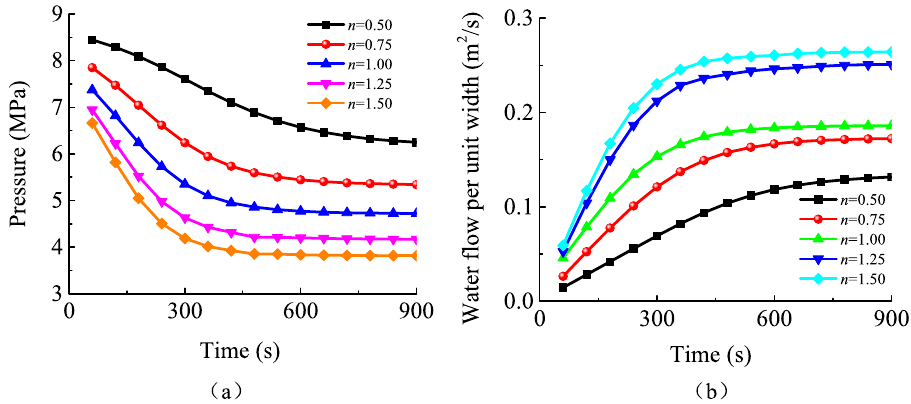
Figure 15. Water inflow and pressure at the entrance of the karst collapse column under different values of n : ( a ) pressure; ( b ) water inflow.